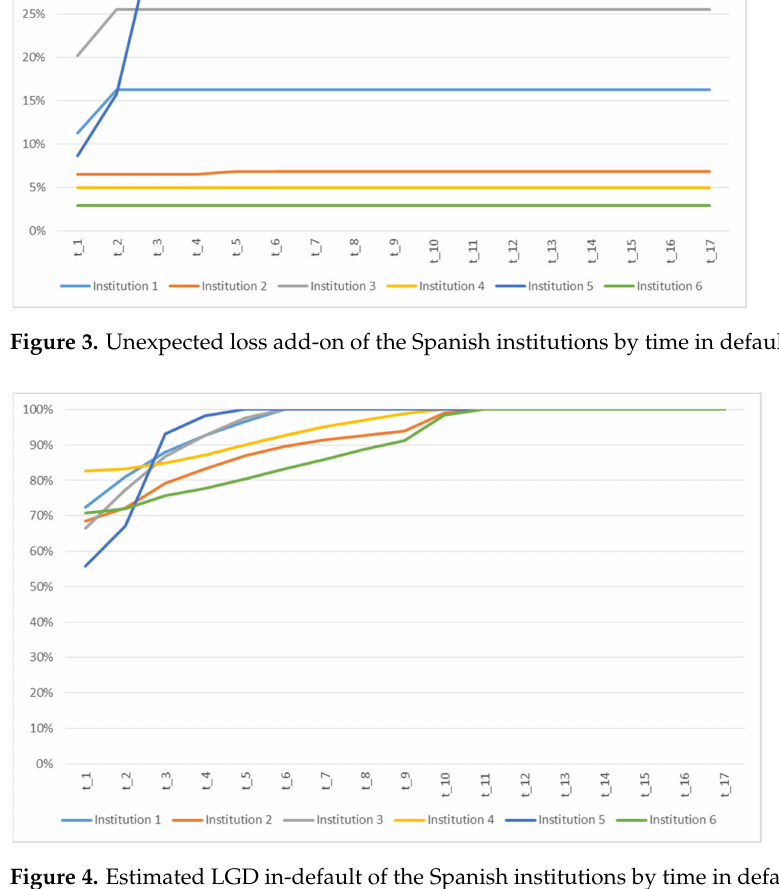
Figure 4. Estimated LGD in-default of the Spanish institutions by time in